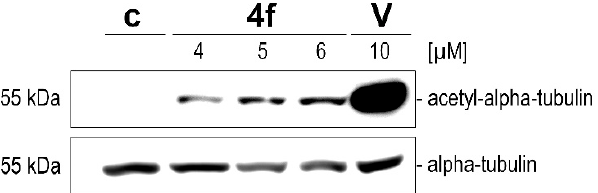
Figure 4. Compound-induced effect on the acetylation of microtubules (acetyl–alpha-tubulin) in 518A2 melanoma cells upon treatment with 4f (4, 5, and 6 µM), SAHA (10 µM), and vehicle (DMSO) for 24 h. Cells were lysed and the levels of the acetyl–alpha-tubulin was monitored by